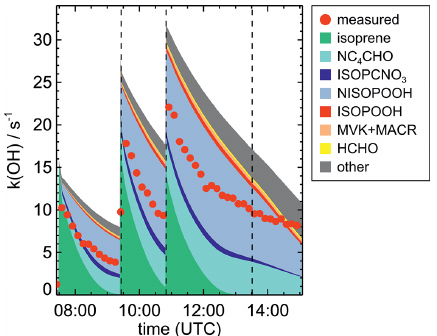
Figure A12. Comparison of measured OH reactivity from or- ganic compounds and OH reactivity calculated from concentrations of organic compounds modelled applying the MCM. Up to 10% of the reactivity from hydroperoxide compounds (NISOPOOH, ISOPOOH) is invisible for the LP-LIF instrument because these species partly produce OH in their reaction with OH. The exact OH yield is uncertain. A 100% yield is assumed in the MCM. OH re- activity from organic compounds is derived by subtracting the re- activity via NO 2 and O 3 calculated using measured concentrations from the measured total OH reactivity. “Other” compounds include a high number of organic compounds that are produced in the reac- tion of isoprene with OH, O 3 and NO 3 and for which loss by the reaction with OH is implemented in the